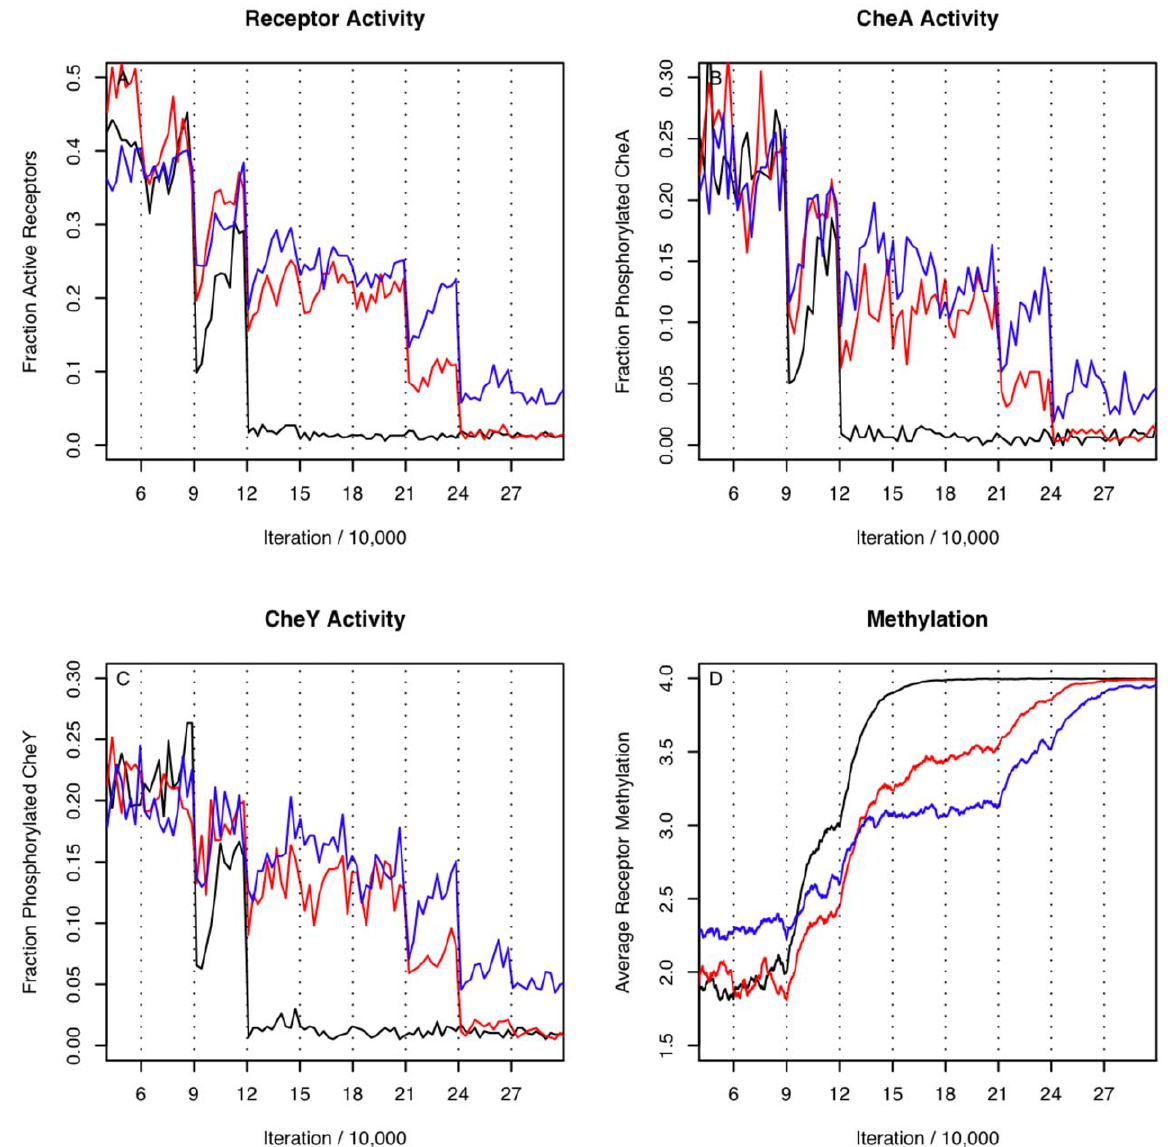
Figure 6. Dynamic range of responses, as a result of ligand addition at varying concentrations. Receptor activity (A), CheA phosphorylation (B), CheY phosphorylation (C) and receptor methylation (D) levels for various ligand increments. Tick marks indicate the iterations at which there was a change in ligand concentration, and were performed at the following iteration numbers and concentrations: (0: 0 M; 30,000: 10 2 8 M; 60,000: 10 2 7 M; 90,000: 10 2 6 M; 120,000: 10 2 5 M; 150,000: 10 2 4 M; 180,000: 10 2 3 M;. 210,000: 10 2 2 M; 240,000: 0.1 M; 270,000: 1 M). The activity of the system reached 0 (saturation) for a homogeneous receptor population (black) at MeAsp concentration of 10 2 5 M, for a heterogeneous population (red): 0.1 M, and for a heterogeneous population (blue) with methylation dependent coupling strength, the activity did not reach 0 during this simulation. The plots for activity levels for receptors, CheA and CheY were smoothed using locally weighted least squares in ‘R’.